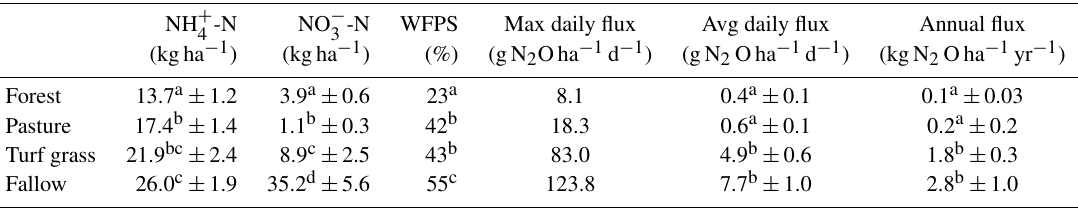
Table 3. Annual mineral N averages of NH + from all treatments with their cumulative annual fluxes over the experimental year with their standard error.